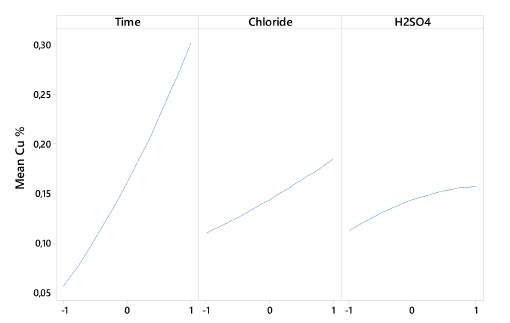
Figure 2. Linear e ff ect plot for Cu